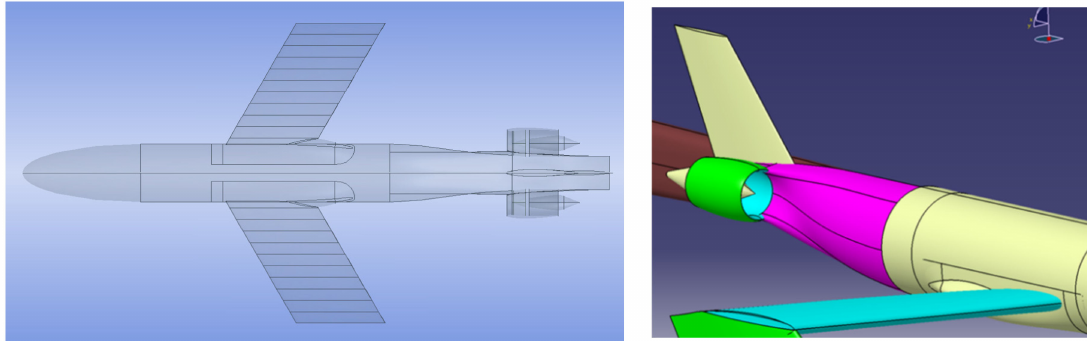
Figure 3. BLI180 configuration designed with two turbofans buried in the fuselage tail